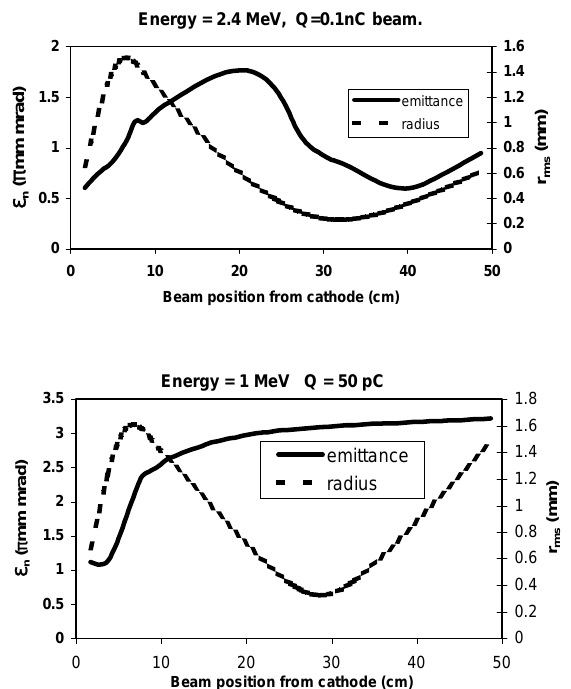
FIG. 5. PARMELA simulation of emittance compensation for a cell gun for the case of a 2 MeV beam (top) and a 1 MeV 1 1 2 beam (bottom). Emittance compensation is shown to be effective for the high energy case.